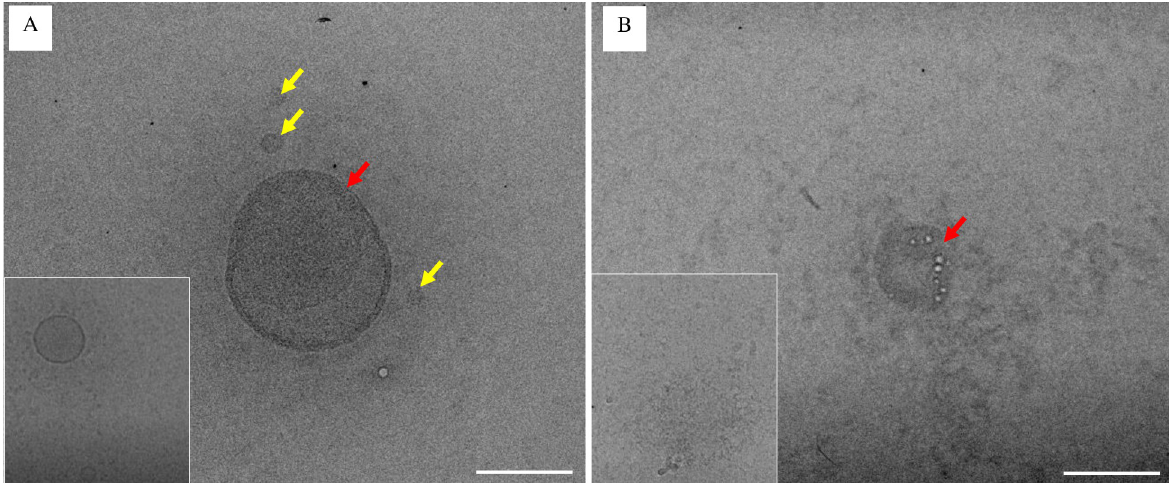
Fig 2. Effect of vinegar on SARS-CoV-2 viral particles by transmission electron microscope (TEM). (A-B) Representative TEM images. (A) The untreated cells, water (- vinegar) SARS-CoV-2 viral particles shows morphodiagnostic features of family Coronaviridae with morphologically intact structure whereas (B) Cells treated with 6% acetic acid (+ vinegar) SARS-CoV-2 viral particles showing presence of abnormal viral morphodiagnostic with misshapen structure with fewer viral particles, and disorganized virion structure. Scale bar = A-B 100nm. Insets are shown from additional images of the same